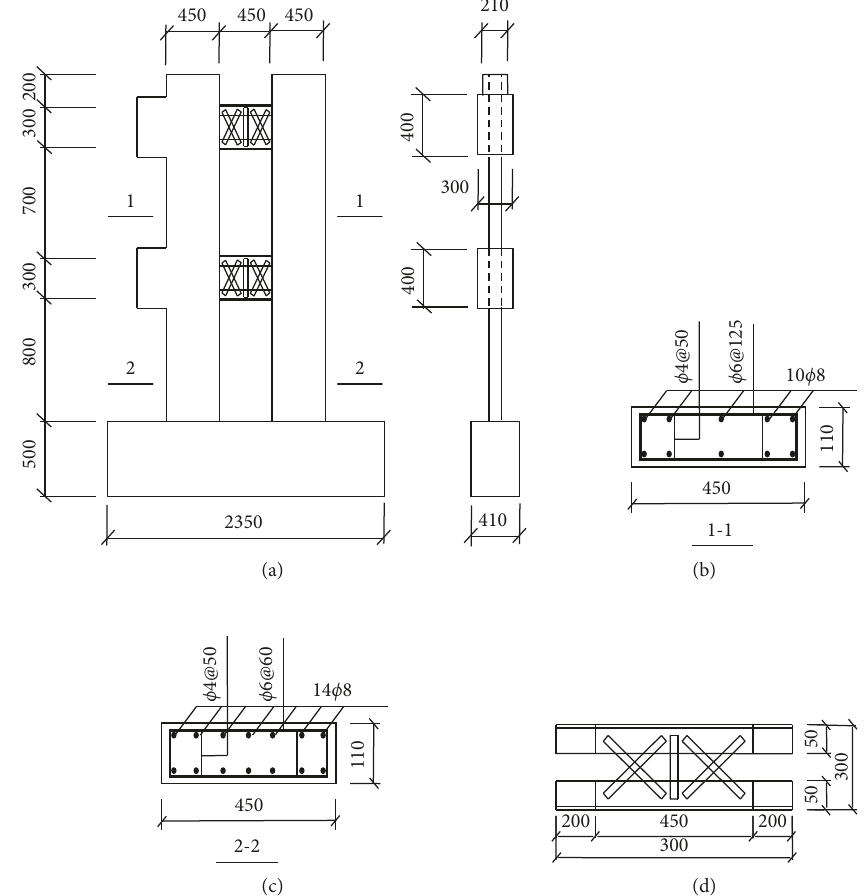
Figure 2: Shear wall specimens with steel truss CBs: (a) elevation; (b) reinforcement details of shear wall on the second floor; (c) re- inforcement details of shear wall on the first floor; (d) dimensions of